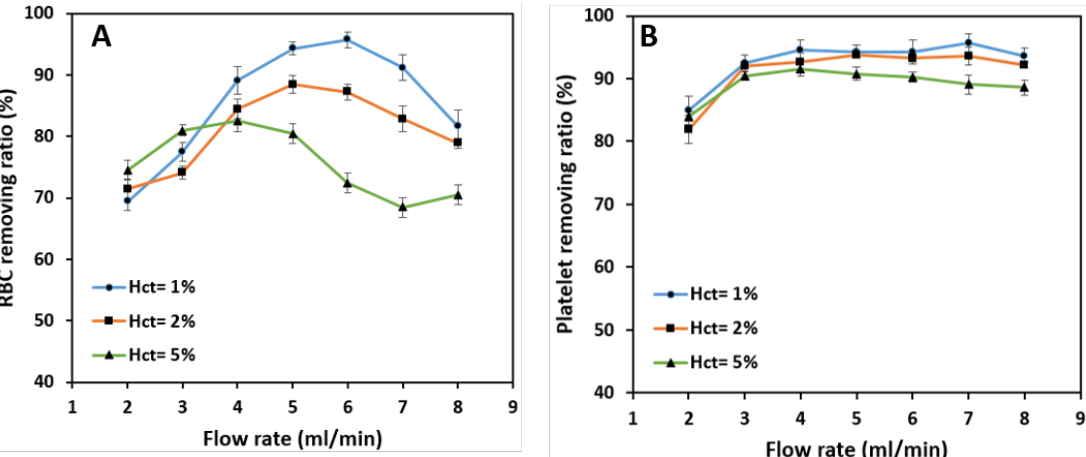
Figure 12. The effect of blood hematocrit on the removing ratio of ( A ) RBC, ( B ) Platelets. The removing ratio mainly decreases with an increase in blood hematocrit due to a rise in the effect of cell-cell interaction. While RBC removing ratio is highly dependent on blood hematocrit, the removing ratio of platelets does not seem to change very much with a change in blood hematocrit.